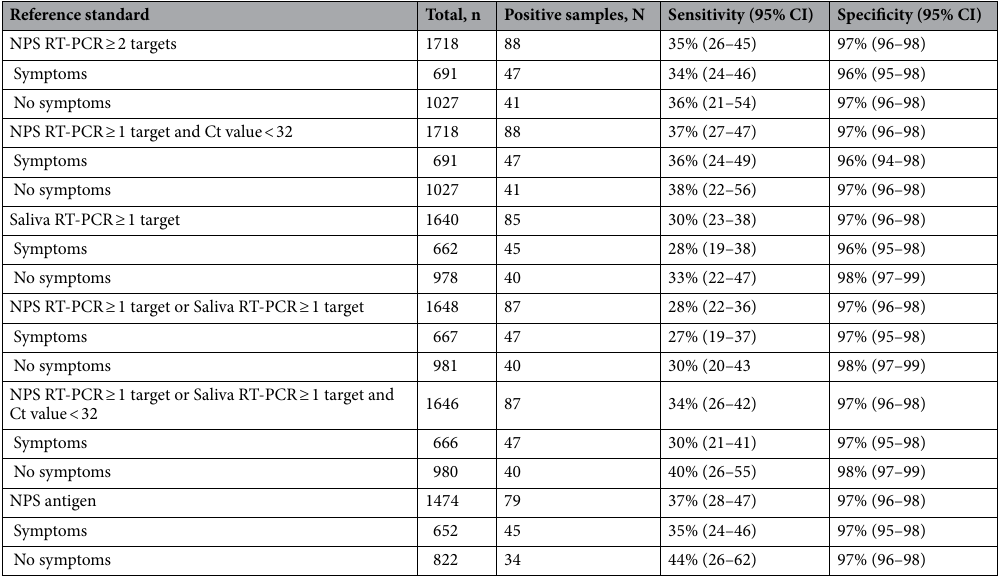
Table 4. Sensitivity analysis of diagnostic accuracy of the saliva RT-LAMP test, as compared to several references. 95% CI 95% confidence interval.